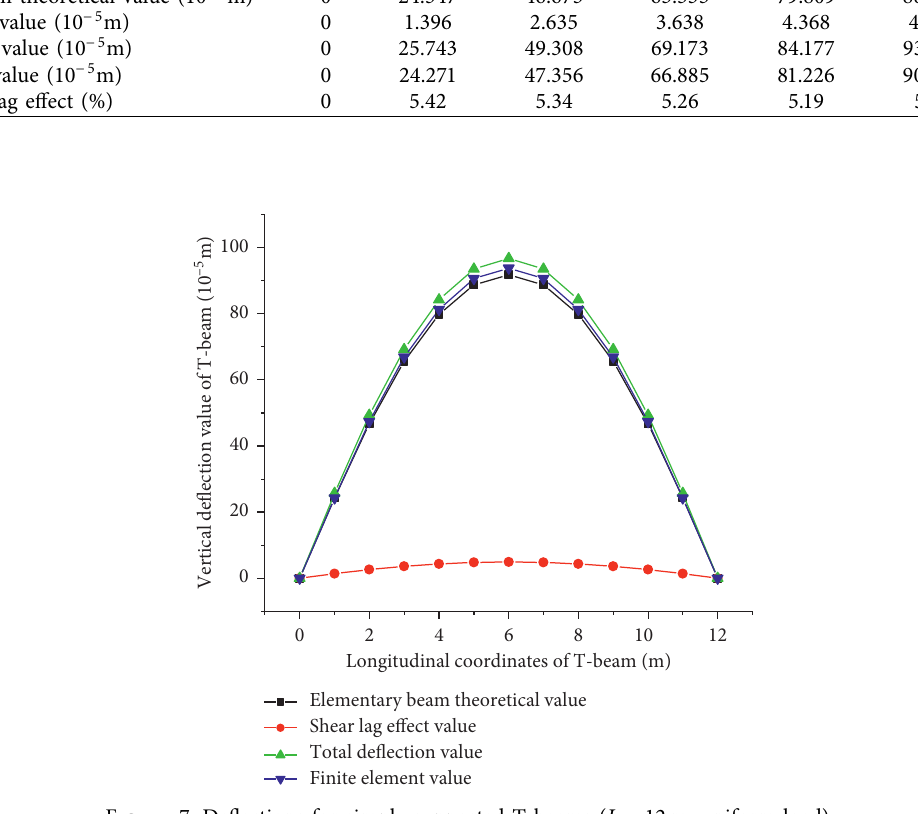
Table 5: Deflection for simply supported T-beams ( z � ( L /2 ) ,L � 12m) (uniform load). Longitudinal coordinates of T-beam (m)